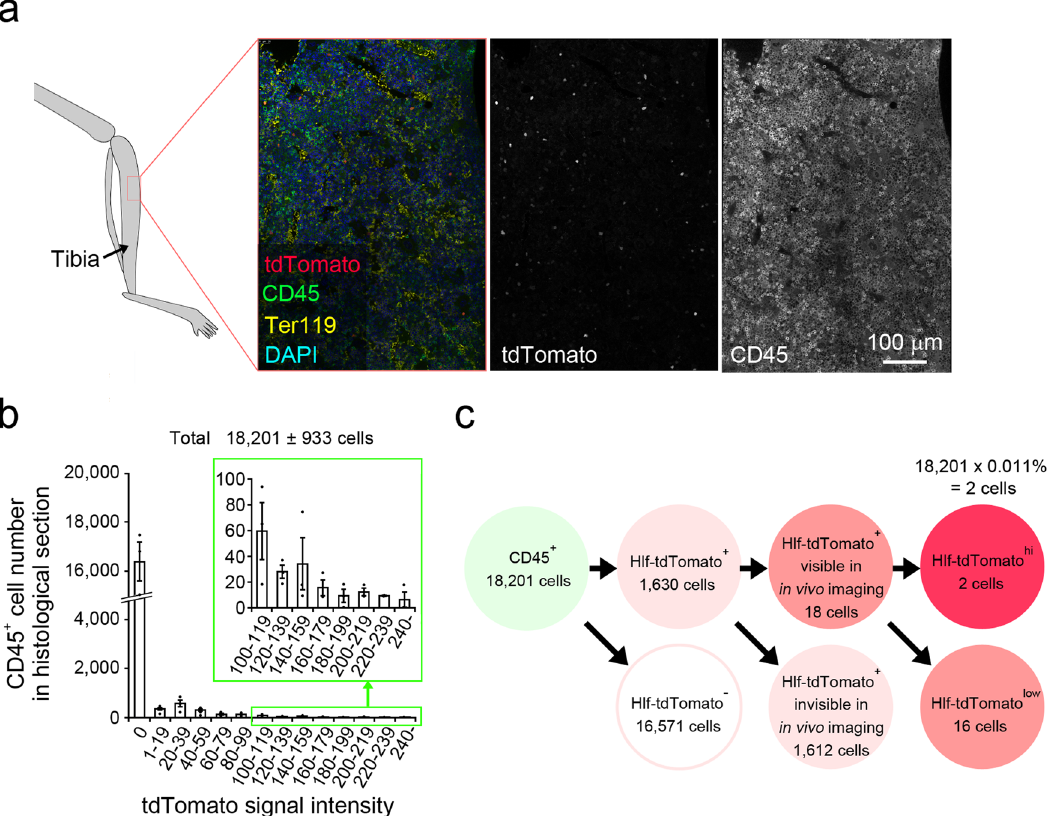
Fig. 3 Identi fi cation of Hlf-tdTomato hi cells in the intravital images. a Immunohistochemical staining of tibial bone sections was obtained from an adult Hlf-tdTomato KI mouse. Ter-119, red blood cell marker; CD45, blood cell marker except for mature red blood cells and platelets; DAPI, nuclear marker. b Fluorescence distribution of tdTomato signals in CD45-positive cells in the histological sections of the tibial bone. The number of CD45-positive cells within the same volume as the in vivo - imaged volume was 18,201 ± 933 cells. Error bars indicate standard error. c The number of CD45 and tdTomato- double-positive cells within the same volume as the in vivo - imaged volume was 1630 ± 269 cells. The number of tdTomato-positive cells was 18.2 ± 1.0 cells, suggesting that the remaining 1612 cells were not visible in the intravital images due to the very low fl uorescent intensity. The cells with the top 0.011% tdTomato intensity in CD45-positive cells were de fi ned as Hlf-tdTomato hi cells (Fig. 1); therefore, the cells with the top two tdTomato fl uorescent intensities in the in vivo images correspond to the Hlf-tdTomato hi cells (18,201 cells × 0.011% = 2 cells). We de fi ned the remaining Hlf-tdTomato-positive cells with lower fl uorescent intensity (16 cells in average) as Hlf-tdTomato low cells for quantitative analysis of Hlf-tdTomato-positive cell dynamics in Figs. 4 and